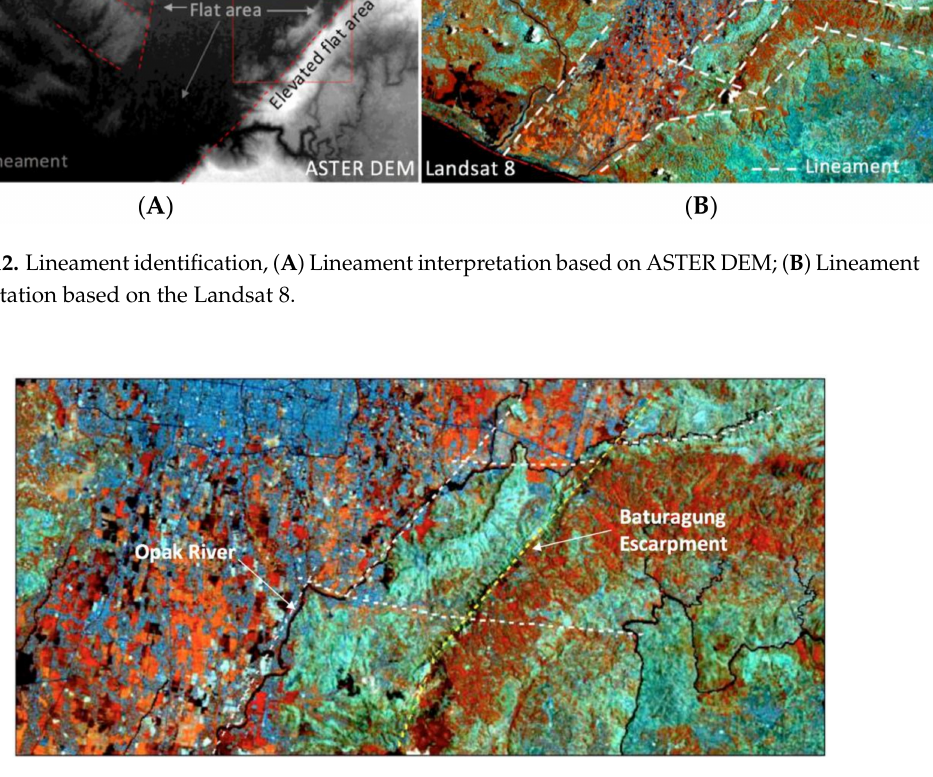
Figure 13. Opak River and Baturagung Escarpment